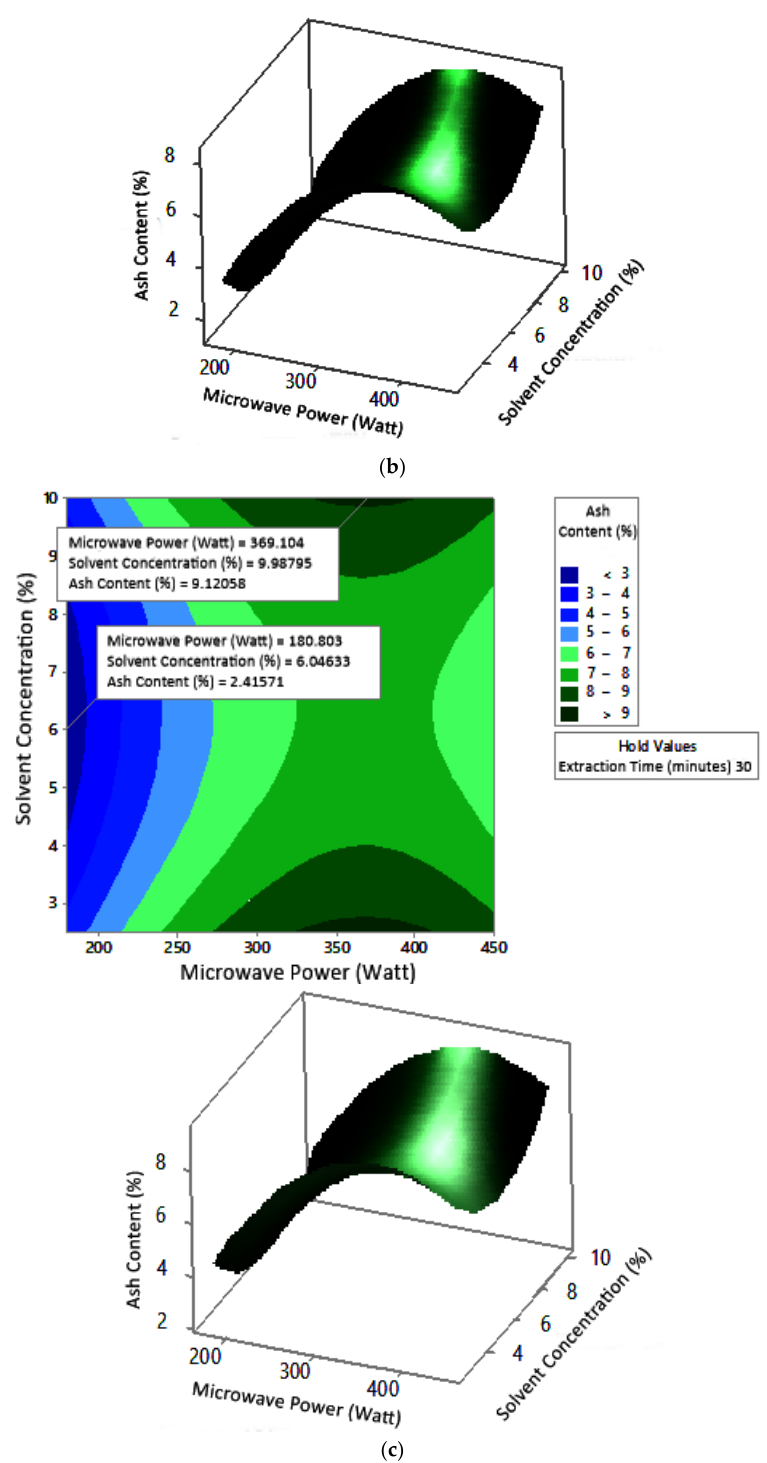
Figure 13. Effect of microwave power and solvent concentration on ash content at extraction times: ( a ) 20 min, ( b ) 25 min, and ( c ) 350